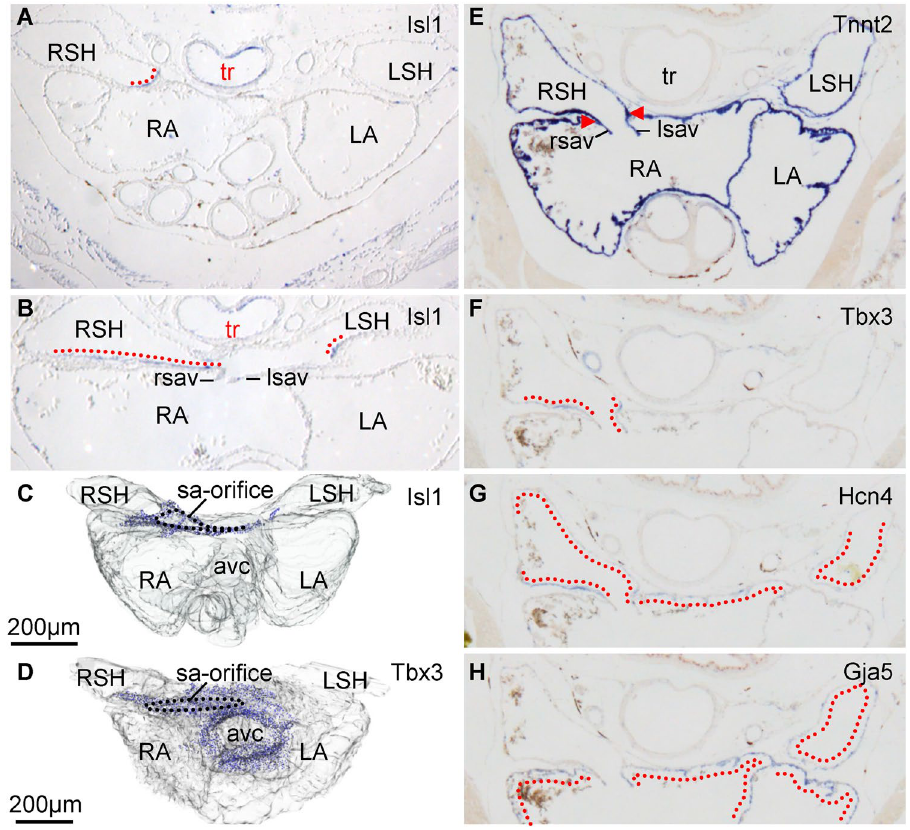
Figure 2. The sinuatrial junction of reptiles has the phenotype of the mammalian sinus node. ( A , B ) In the near- hatching Anolis sagrei, Isl1 was detected cranial to the sinuatrial junction ( A ), where the sinus node is found in mammals, at the base of the sinuatrial valve and in the most proximal part of the left sinus horn ( B ). ( C , D ) The domain of Isl1 ( C ) overlaps with the domain of Tbx3 ( D ). ( E–H ) The anole sinus myocardium proximal to the sinuatrial junction expresses Tbx3 and Hcn4 , but not Gja5 . avc, atrioventricular canal; lsav, left leaflet of the sinuatrial valve; LA, left atrium; LSH, left sinus horn; RA, right atrium; rsav, right leaflet of the sinuatrial valve; RSH, right sinus horn; sa-orifice, sinuatrial-orifice; tr,